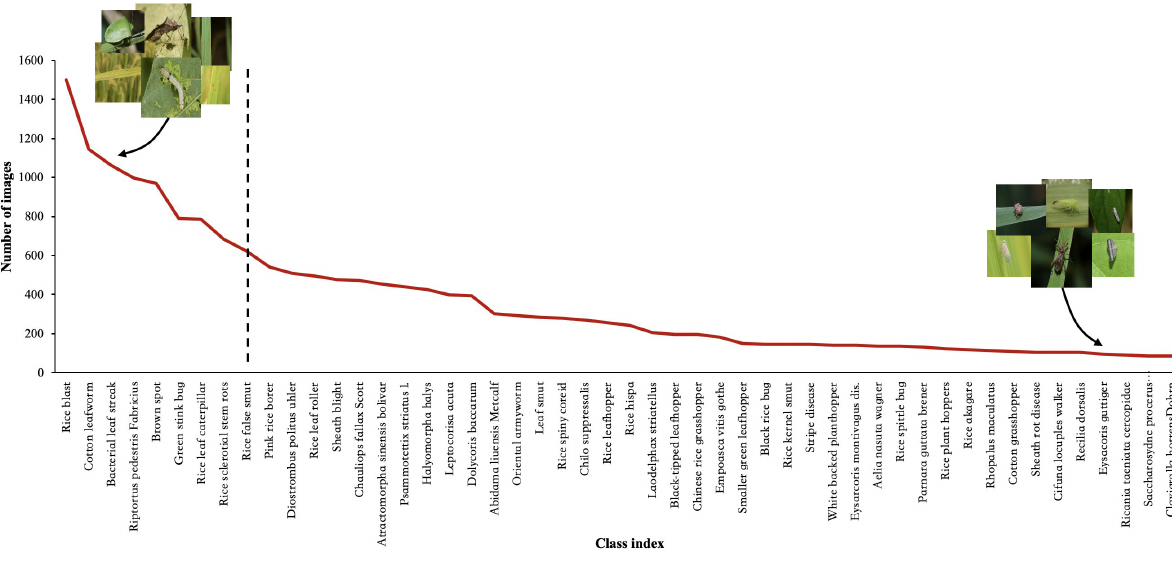
FIGURE 1 | The imbalanced phenomenon of rice pest and disease images collected in the